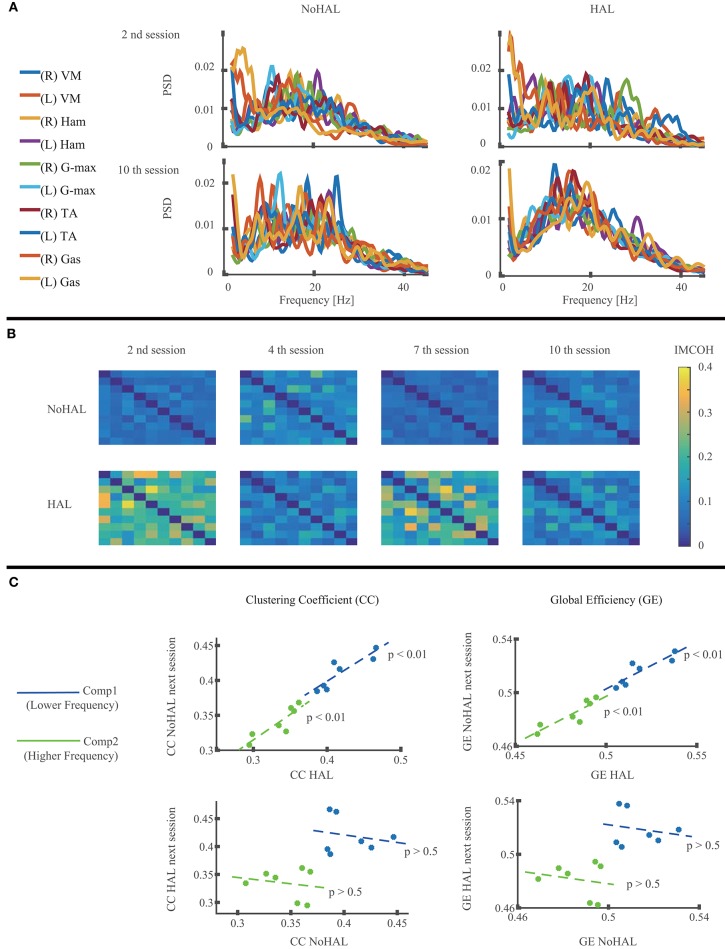
Muscle network analysis of EMG during walking without Hybrid Assistive Limb (HAL) and with HAL in each session. (A) Power spectral density (PSD) of the measured muscles in the second and 10th HAL sessions. (B) Intermuscular coherence (IMCOH) between the measured muscles in the second, fourth, seventh, and 10th HAL sessions, averaged through frequency. The order of the muscles is the same as in the muscle list in (A), from top to bottom and from left to right. Color scale is shown on the right. (C) Linear regression of the clustering coefficient (CC) during HAL and CC during NoHAL in the next session (top left), CC during NoHAL and CC during HAL in the next session (bottom left), global efficiency (GE) during HAL and GE during NoHAL in the next session (top right), and GE during NoHAL and GE during HAL in the next session (bottom right). The scatter plot is plotted and regressed for the averages on the lower frequency ranges (blue, 2–22 Hz) and higher frequency ranges (green, 22–44 Hz).